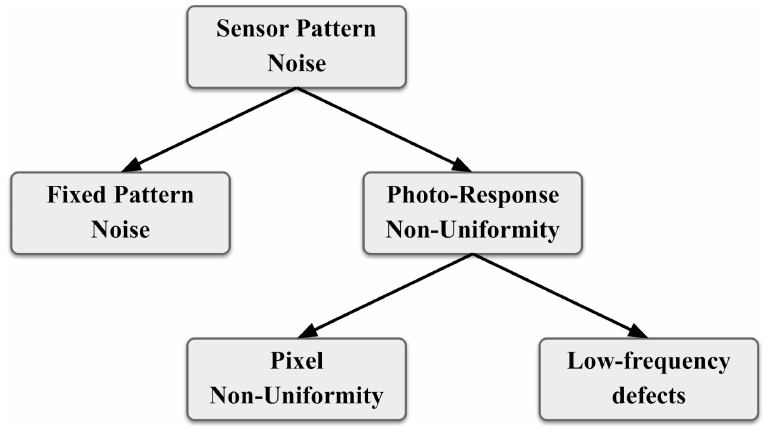
Figure 2. Sensor patter noise